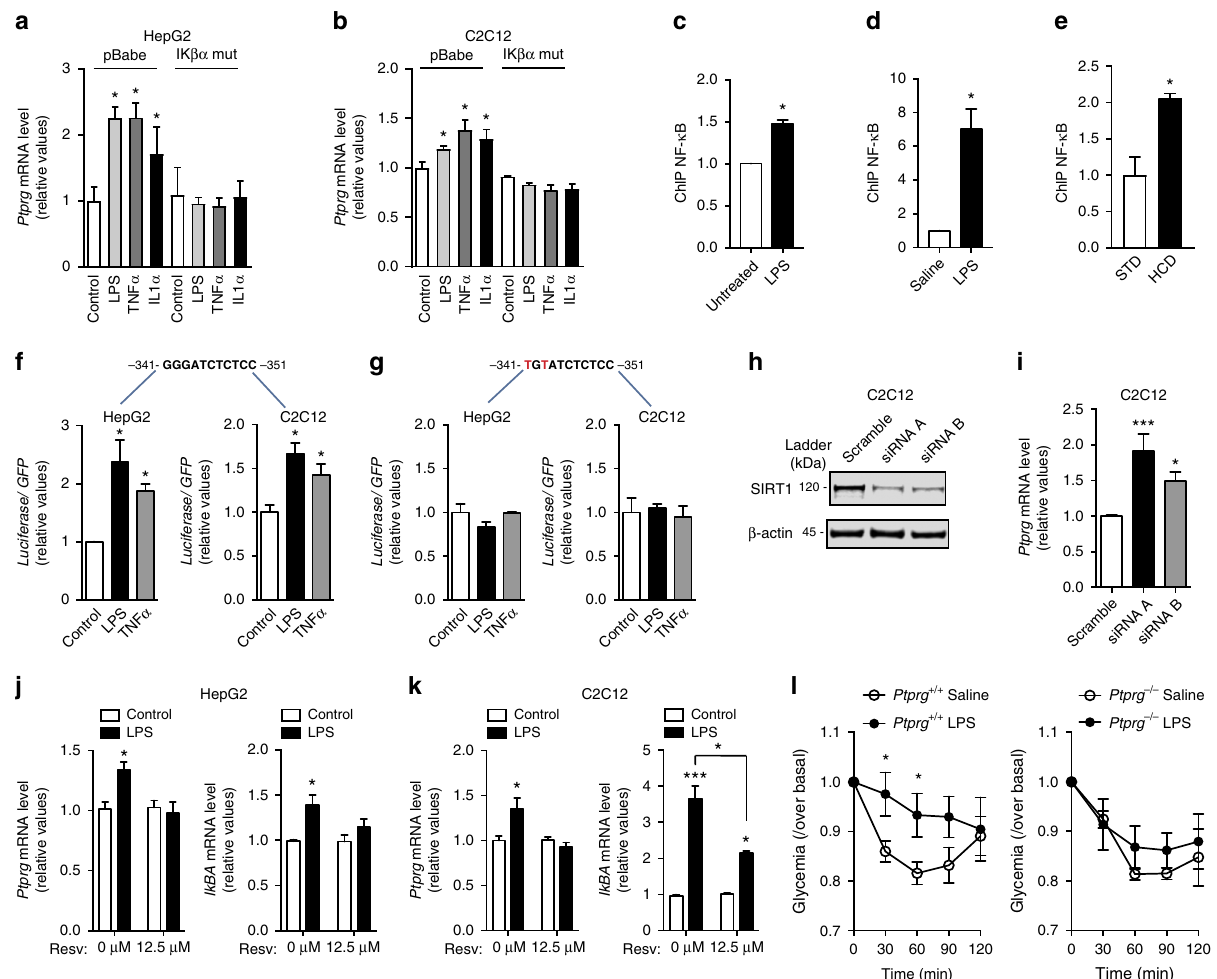
Fig. 4 NF- κ B mediates in fl ammation-induced PTPR- γ expression. a Ptprg mRNA level in HepG2 cells and b C2C12 cells treated as indicated. (I κ B α DN expresses a mutant “ super-repressor ” allele of I κ B α harboring two amino acid substitutions: Serine 32 and 36 are substituted in Alanine). c ChIP analyses of NF- κ B in C2C12 cells treated with LPS or vehicle (relative data are represented over IgG controls). d , e ChIP analyses of NF- κ B in liver of mice treated with saline or LPS and STD or HCD (relative data are represented over IgG controls). f , g mRNA levels of Fire fl y luciferase in HepG2 and C2C12 cells transduced with pGL2-basic plasmid containing Ptprg promoter region containing a mutated/disrupted NF- κ B putative binding motif and treated as indicated. h Knockdown in HepG2 cells of SIRT1 using two different siRNAs and i Ptprg mRNA level in the same cells. j , k Ptprg mRNA level in HepG2 and C2C12 cells treated with resveratrol as indicated. l Insulin tolerance test (ITT) in 12-week-old mice treated 28 days with LPS (the dose of insulin injected intra-peritoneally is 0.75 U/kg). Error bars represent SEM. Statistical analyses were done using two-tailed unpaired Student ’ s t test or using one-way ANOVA (Tukey ’ s post test). * P < 0.05, ** P < 0.01, *** P < 0.001. See also Supplementary Fig.